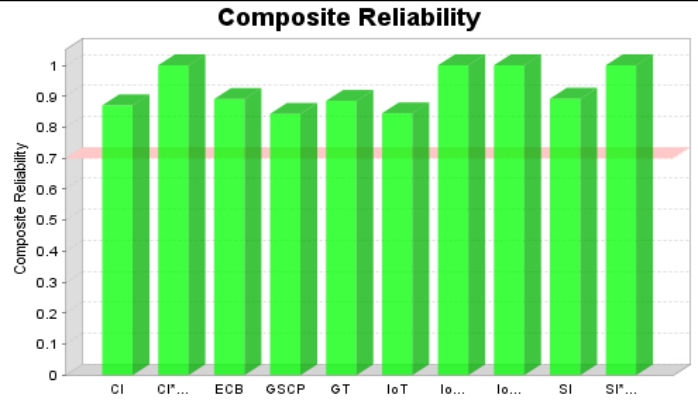
Figure 3. Composite reliabilities of research variables.